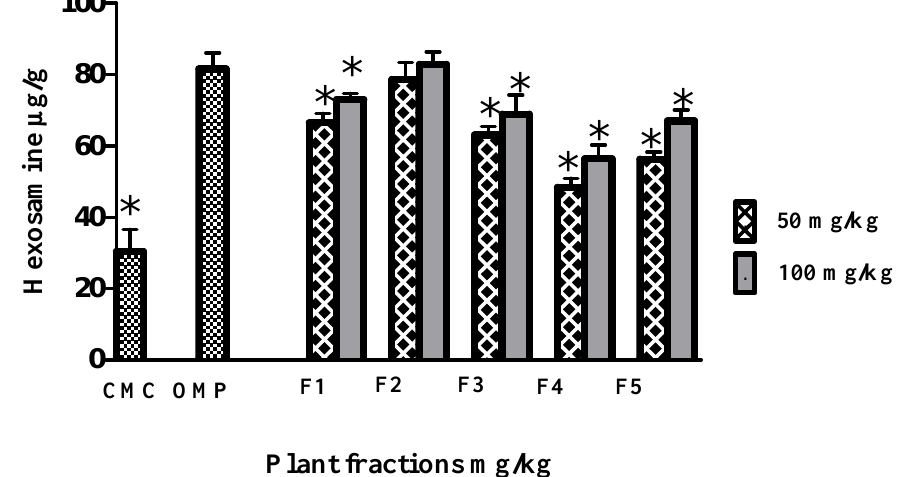
Figure 6. Effect of the fractions obtained from Polygonum minus on the hexosamine content in gastric tissue. Data expressed as mean ± SEM ( n = 6). * significantly different in comparison to omeprazole, p < 0.05 using one-way ANOVA